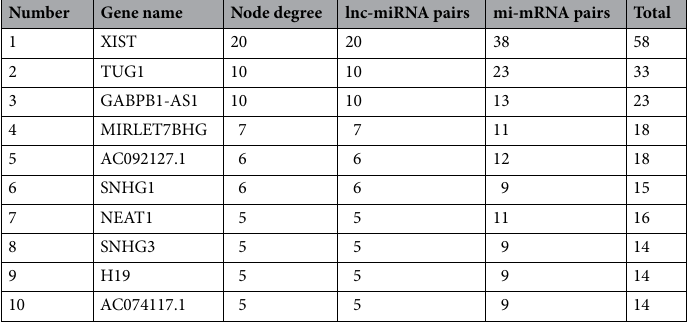
Table 1. The topological algorithm of differentially expressed lncRNAs